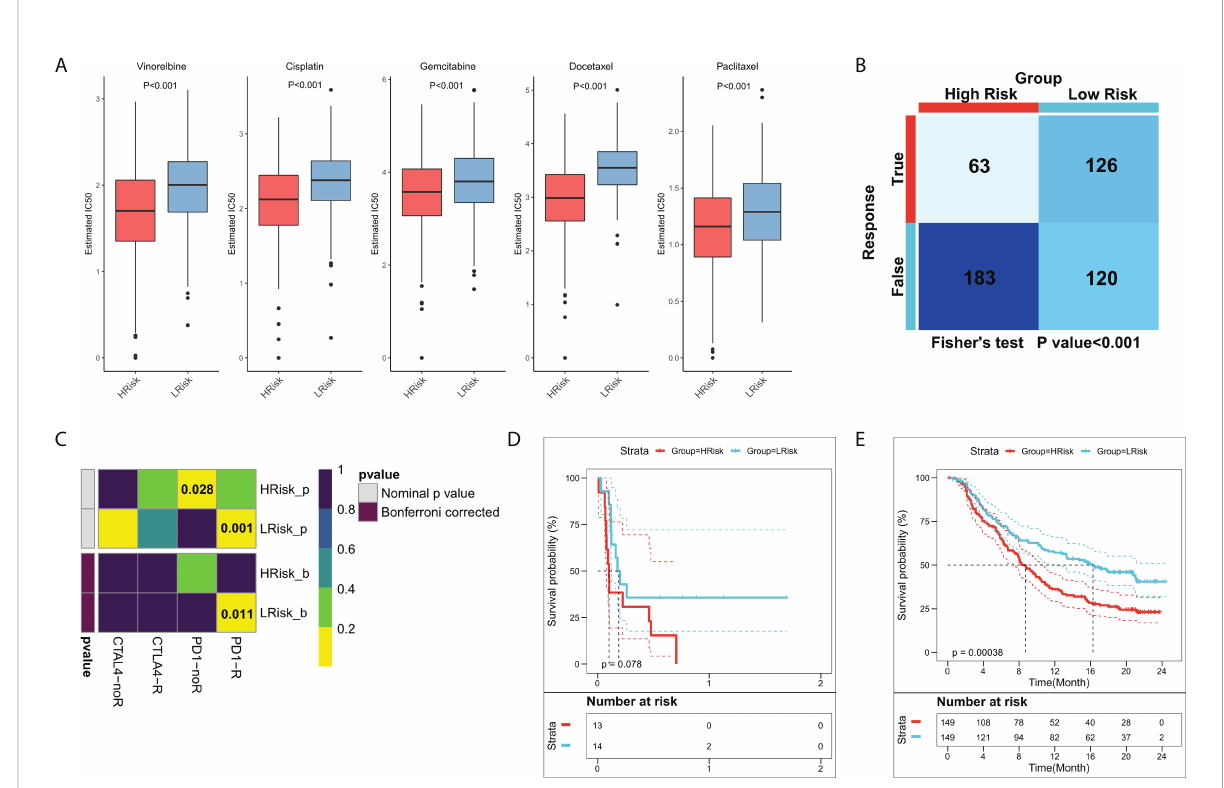
FIGURE 8 Role of the FRS-related risk model in guiding clinical treatment decisions. (A) Box plots showing the predicted IC50 values for the fi ve most commonly used drugs in high- and low-FRS groups; (B) Predicted responses to immunotherapy for patients in the high- and low-FRS groups using the TIDE algorithm; (C) Sensitivity of patients in the high- and low-FRS groups to PD1 and CTLA4 treatment regimens predicted by subclass mapping; (D) KM survival curves for patients in the high- and low-FRS groups in GSE135222 cohort; (E) KM survival curves for patients in the high- and low-FRS groups in IMvigor210